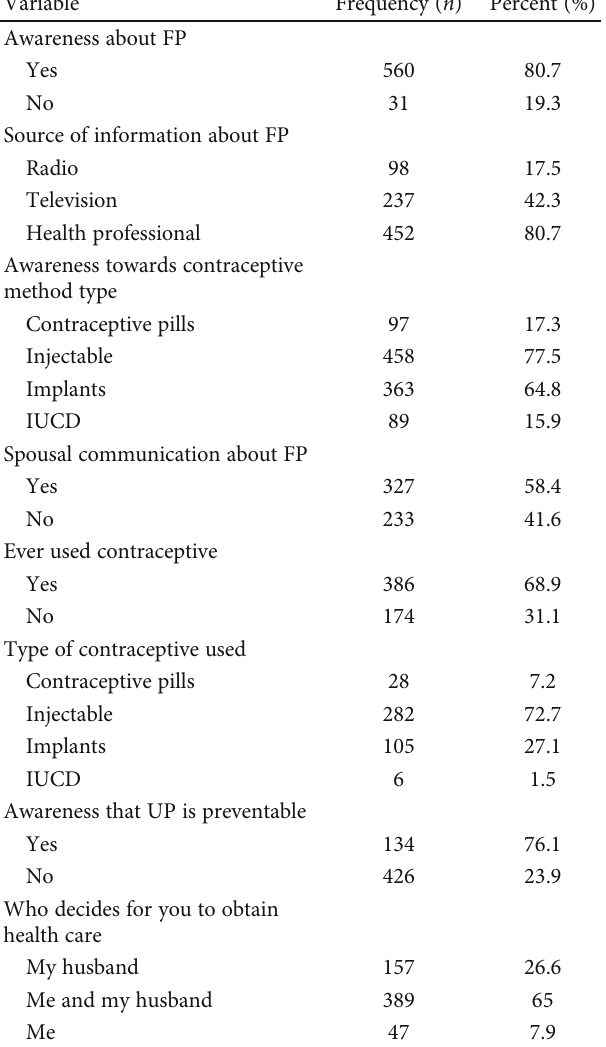
Table 3: Awareness towards contraceptive method of pregnant women attending ANC in a public health facility in Bako Tibe district, Oromia, Ethiopia, 2019 ( n = 591